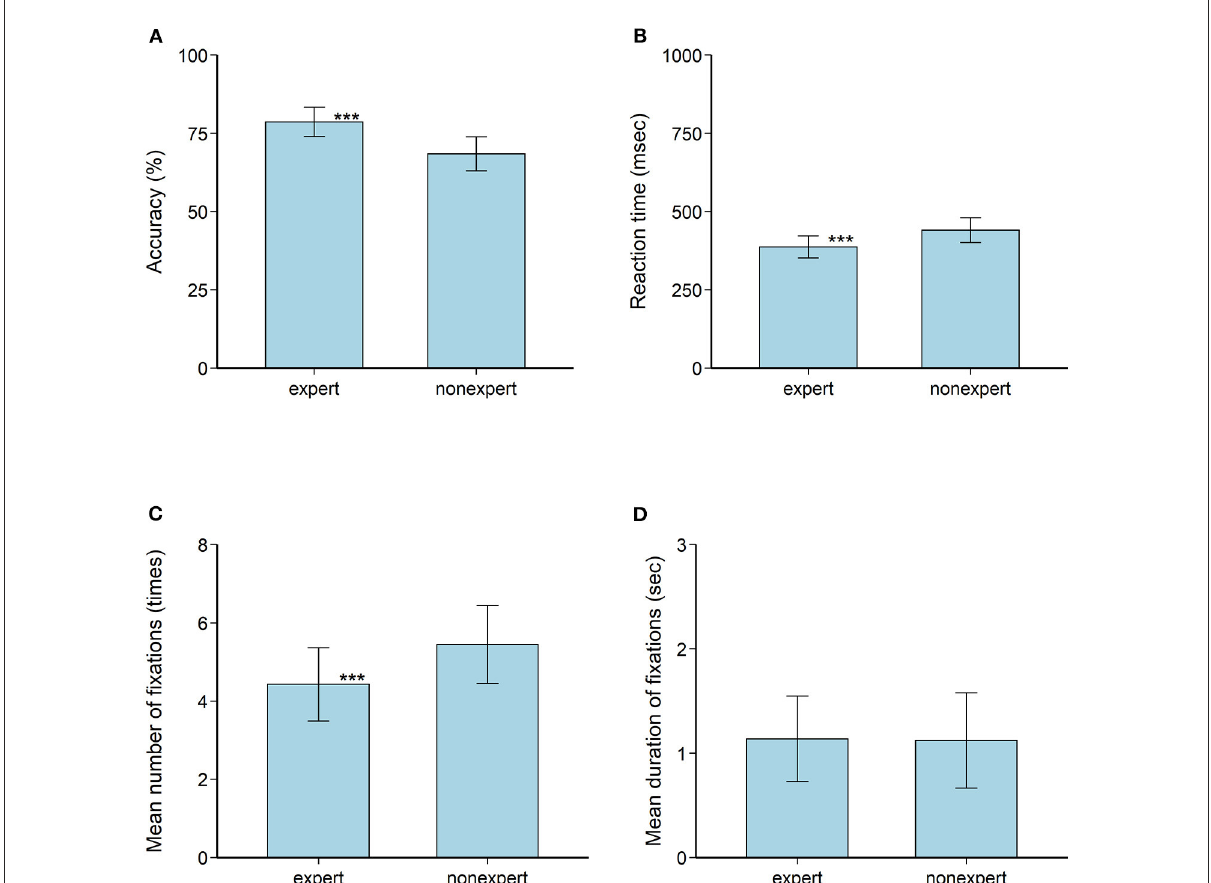
FIGURE2 Pooled analysis of four indicators associated with perceptual anticipation among the expert and non-expert groups. (A) Accuracy. (B) Reaction time. (C) Mean number of fixations. (D) Mean duration of fixations. The vertical line represents the 95% confidence interval. The asterisks denote significant differences between the expert and non-expert groups for certain indicators.